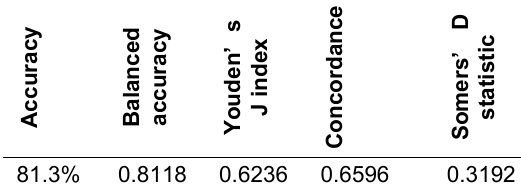
Figure 6. Comparing accuracy of algorithms Figure 7 represents a plot comparing four